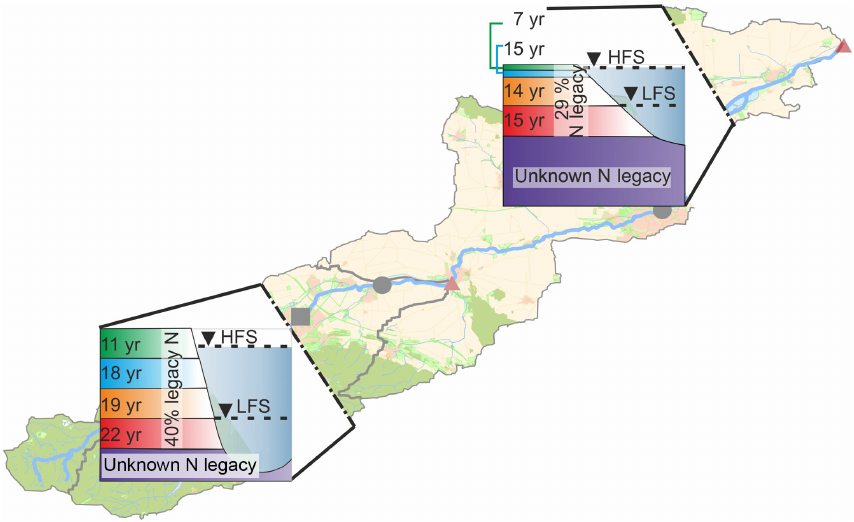
Figure 7. Conceptual model of nitrogen legacy and exports from the midstream and the downstream catchments. The four stacked boxes refer to the dominant source layer of nitrate that is activated with changing water level and catchment wetness during low-flow seasons fall (red) and autumn (orange) as well as high-flow seasons winter (blue) and spring (green). Numbers in the boxes refer to peak travel times of each season. The percentages refer to the N imbalance between input and output explainable by travel times (hydrological legacy). Background map created from ATKIS